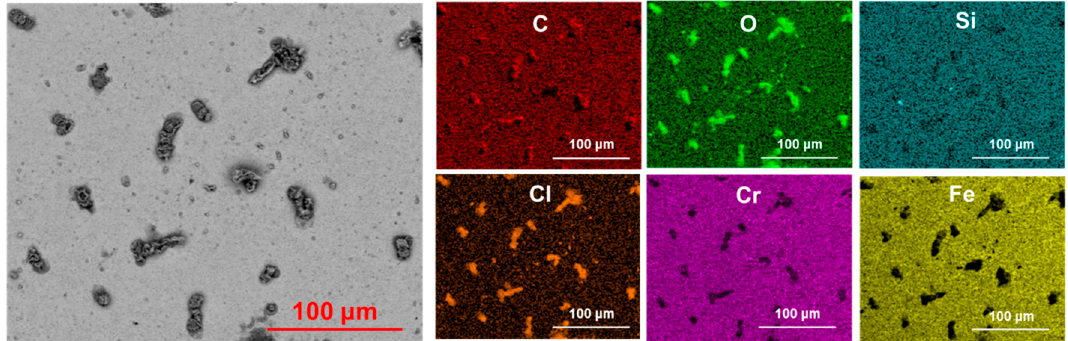
Figure 8. SEM images and corresponding EDX images of the cathodic region on the BPE.